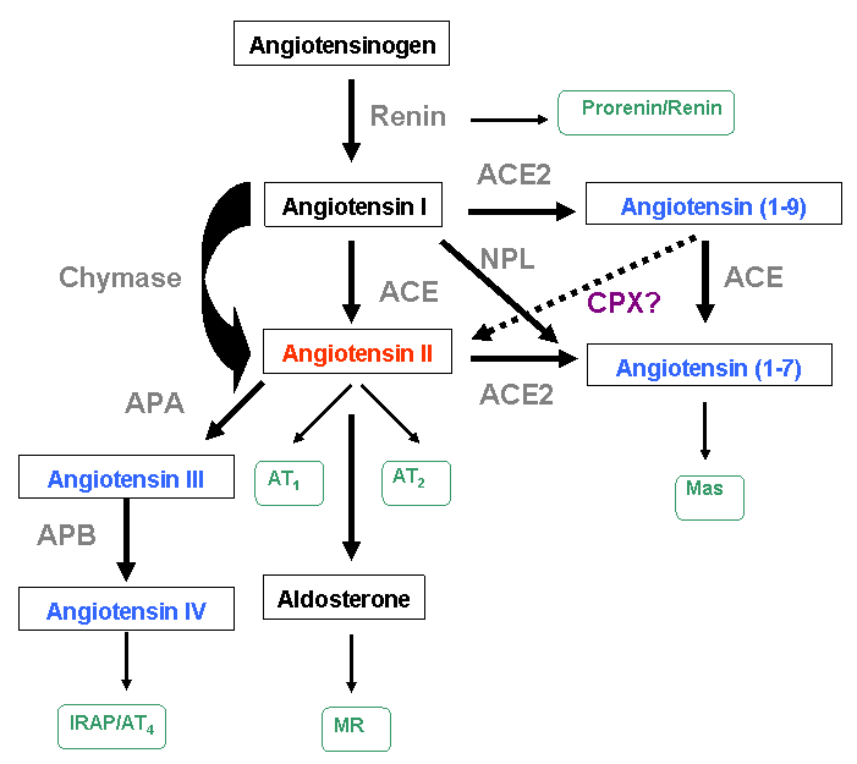
FIGURE 2. The current view of the RAAS showing the “classical” pathway of Ang II formation and the more recently identified enzymes, metabolites, and receptors of the RAAS. Abbreviations: ACE: angiotensin converting enzyme; ACE2: angiotensin converting enzyme-2; AT 1 : angiotensin II type 1 receptor; AT 2 : angiotensin II type 2 receptor; APA: aminopeptidase A; APB: aminopeptidase B; CPX: unknown carboxypeptidase; IRAP: insulin-regulated aminopeptidase; MR: mineralocorticoid receptor; NPL: neprilysin; Mas protooncogene; AT 4 : angiotensin IV